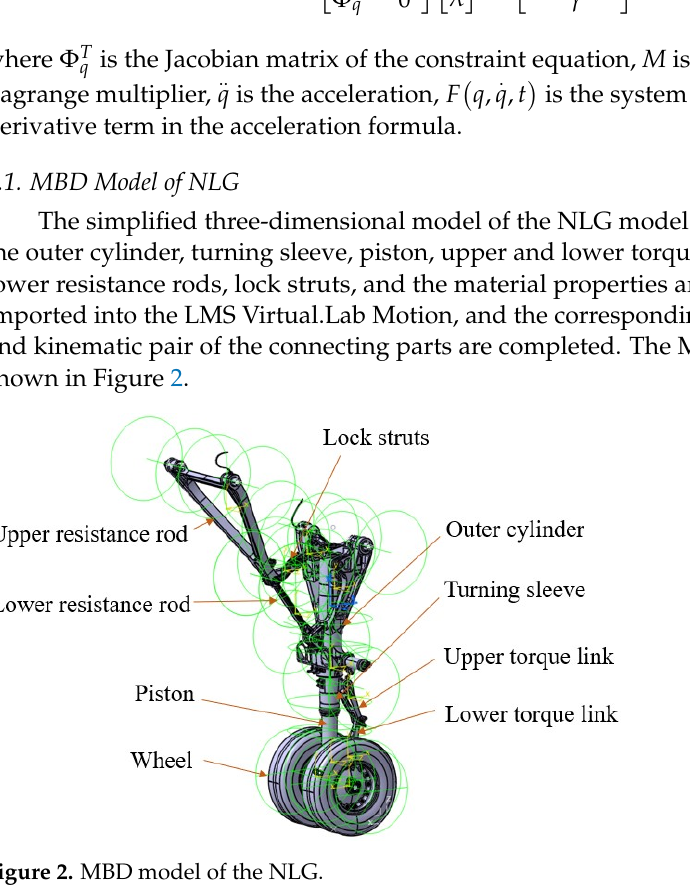
Figure 1. Coordinate system and main parameters of aircraft taxiing.